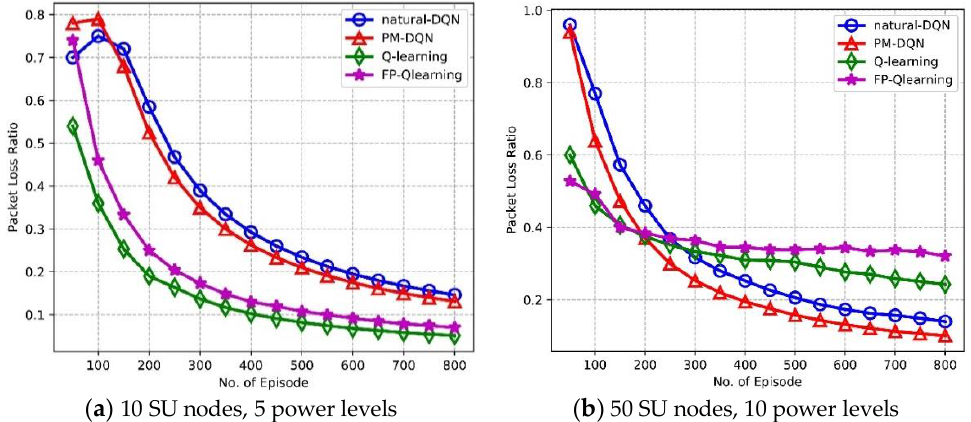
Figure 11. Packet loss ratio vs. the number of episodes.